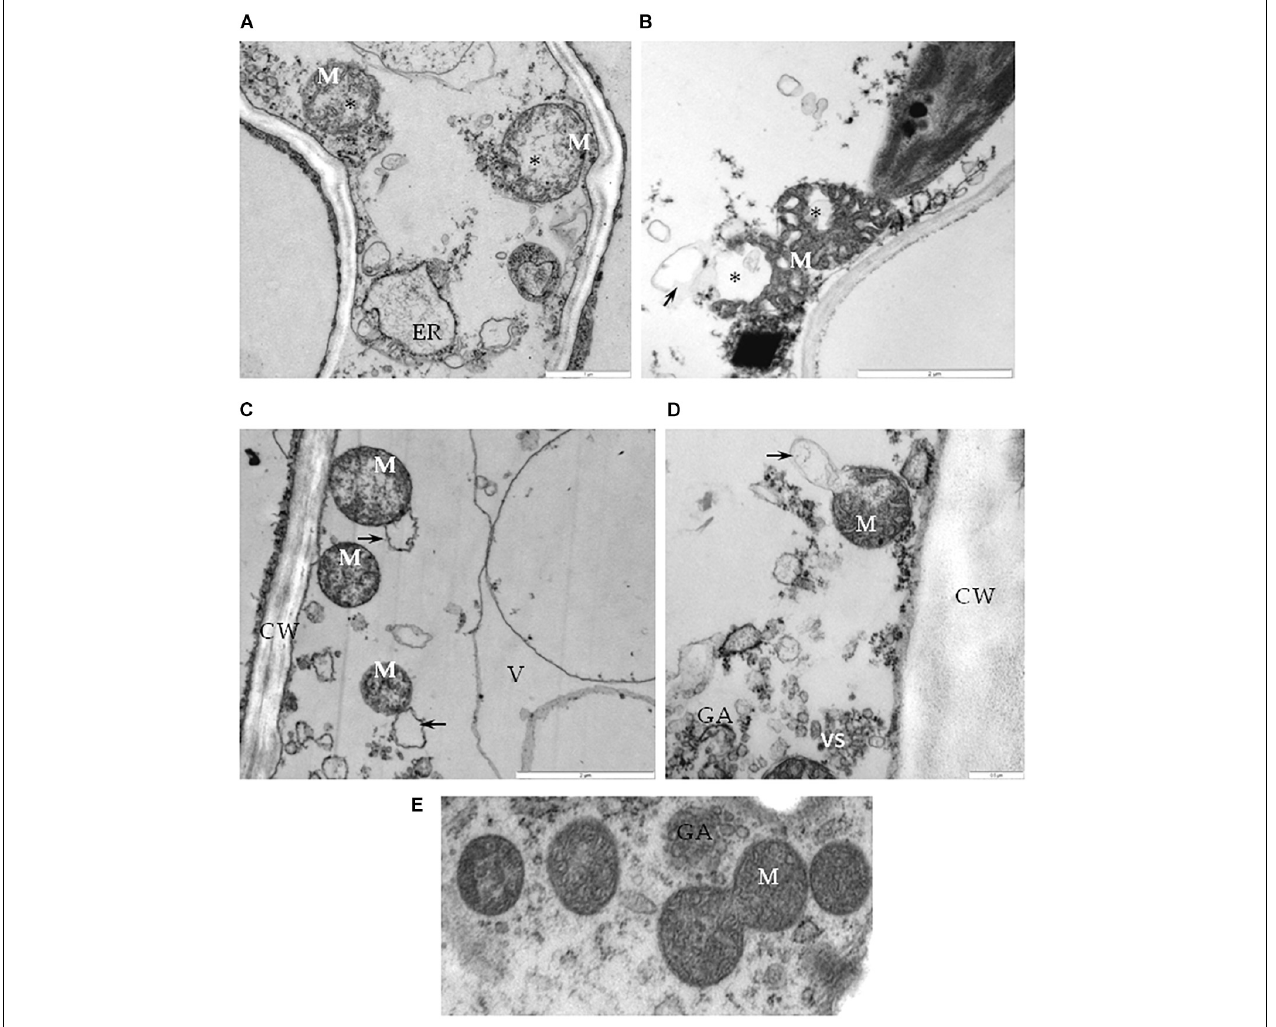
FIGURE 6 | Alterations of mitochondria in cells of BPEV-infected tissues. (A) Mitochondria (M) with electron-lucent area (*) and expanded endoplasmatic reticulum (ER) in phloem parenchyma cell. Bar 1 µ m. (B) Mitochondria (M) with an electron-lucent area (*) forming a vesicle-like structure (arrow) in mesophyll cell. Bar 2 µ m. (C) Mitochondria (M) forming exosome like vesicles (arrows) in phloem parenchyma cell. CW-cell wall, V- vacuole. Bar 2 µ m. (D) Mitochondria (M) with exosome like structure (arrow) in phloem companion cell. GA- trans Golgi network, vs-vesicles. Bar 0.5 µ m. (E) Mitochondria (M) of a BPEV-free mesophyll cell. GA- trans Golgi network Bar 0.5 µ